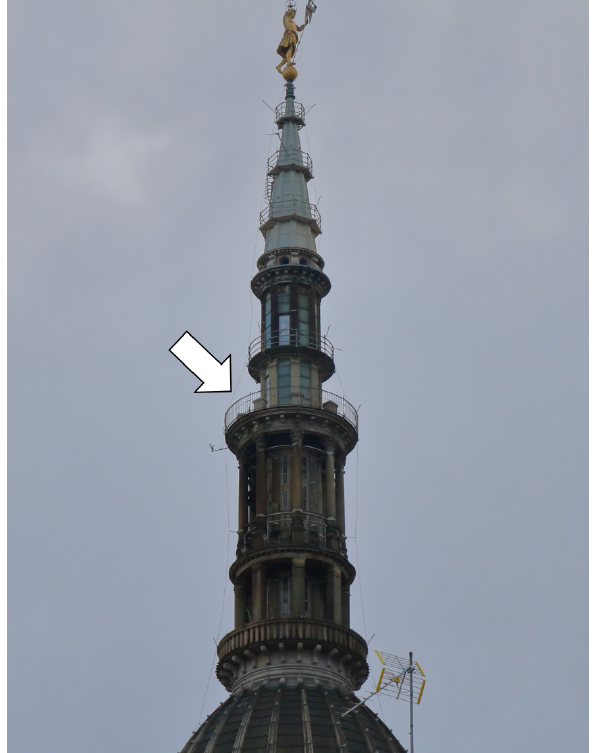
Figure 1. San Gaudenzio’s spire; the arrow indicates the second peristyle where the antennas are located